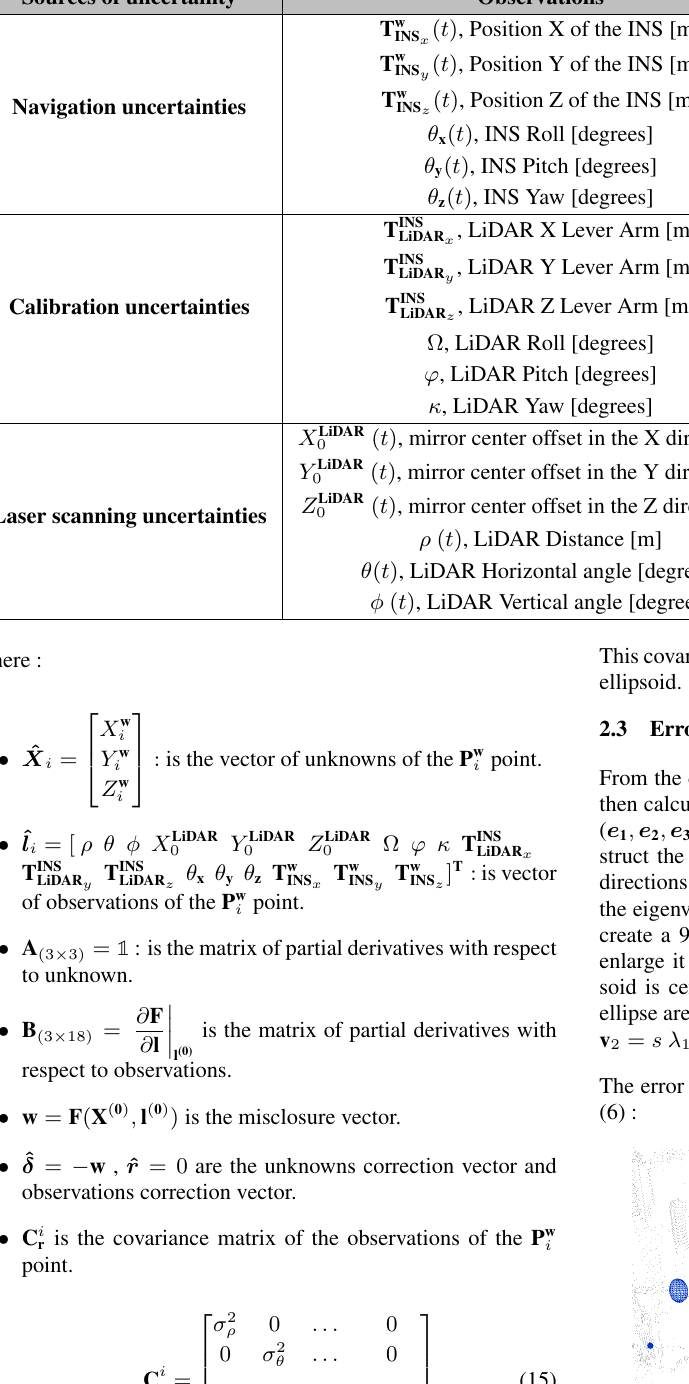
Table 1: Sources of uncertainty in MTLS Sources of uncertainty